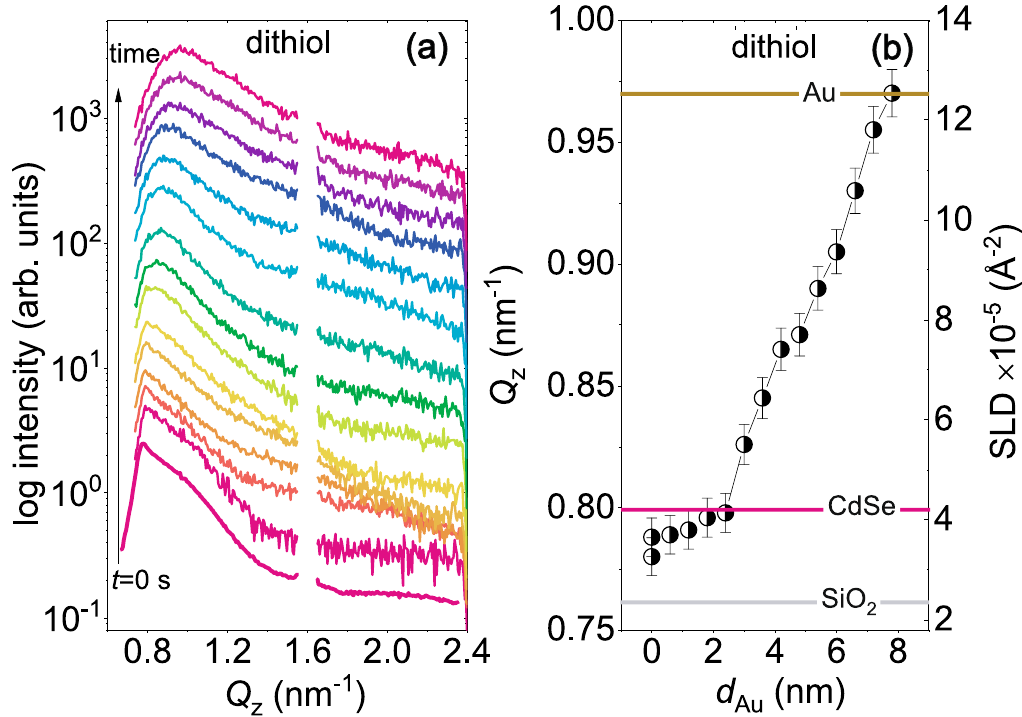
Figure 5. ( a ) One-dimensional vertical line cuts from the 2D GISAXS data at Q y = 1.1 nm − 1 for a selected Q z range measured for QD arrays prepared using dithiol . The Au thickness ranges from, d Au = 0 nm to 8.0 nm for this data selection. ( b ) The shift in the Q z values and the corresponding SLD values as a function of d Au